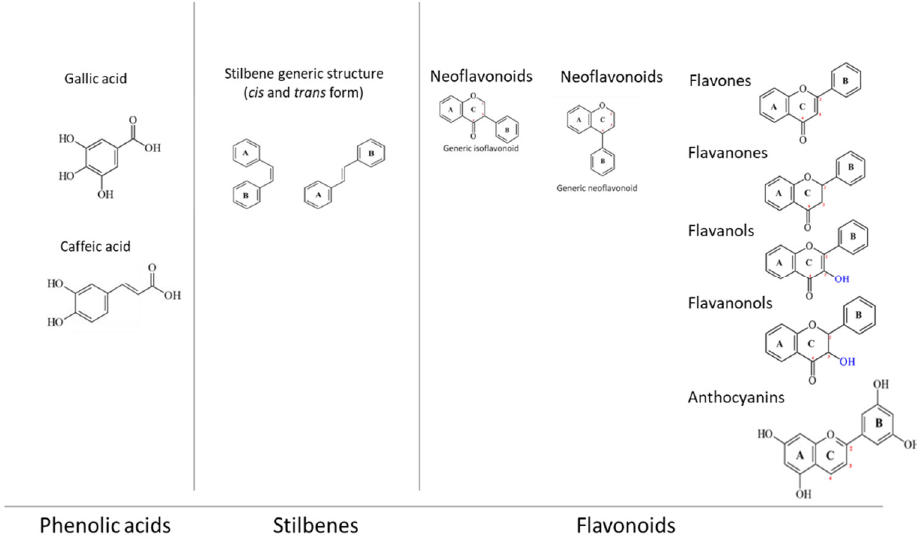
Figure 1. Examples of polyphenols applied as antimicrobials.